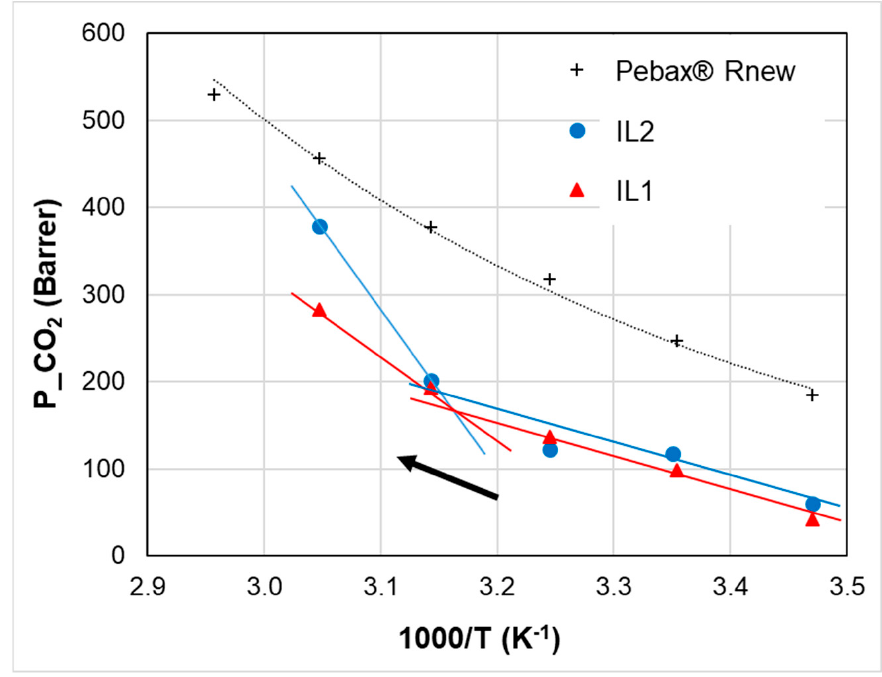
Figure 10. Temperature effect on CO 2 permeability for Pebax ® Rnew and Pebax ® Rnew–IL composite membranes at 20% of IL loading. Heating mode. Lines are a guide for the eyes.